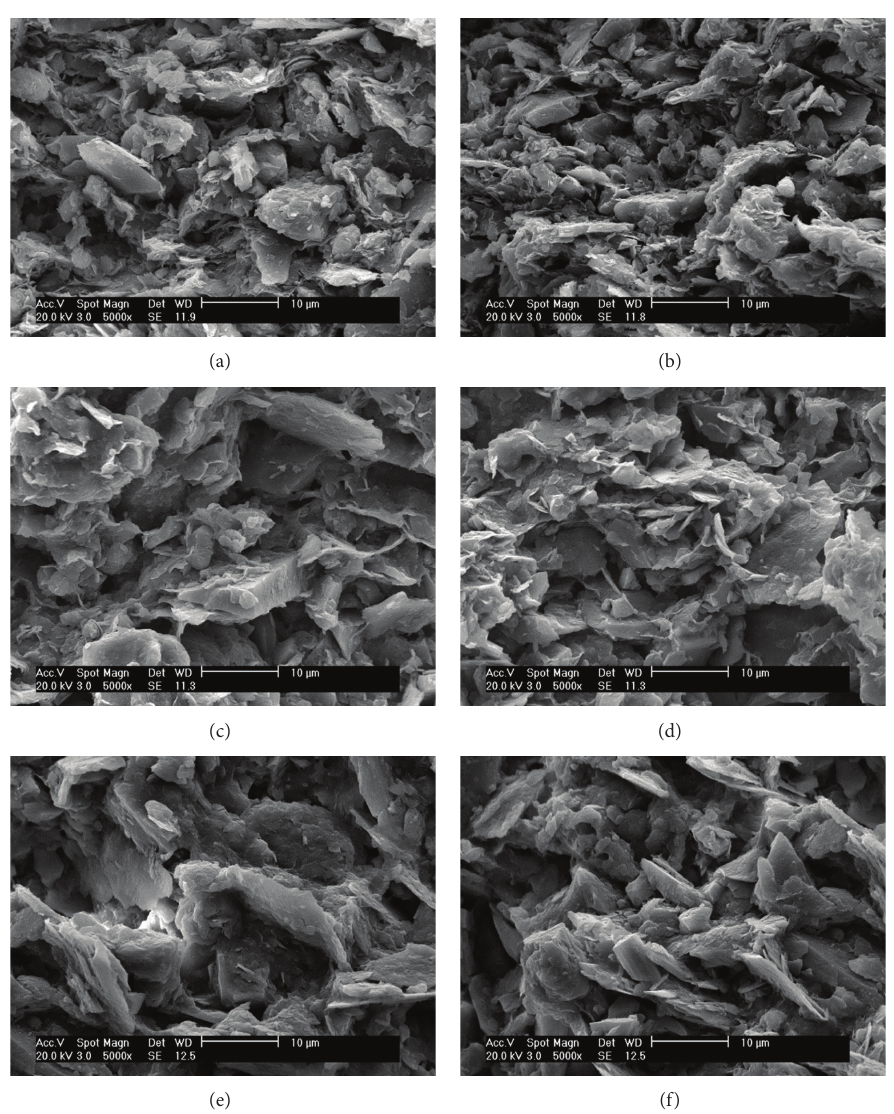
Figure 5: Microstructure of RAC with different replacement and corrosion time. (a) RP = 0% (before test). (b) RP = 0% (8 months corrosion). (c) RP = 30% (before test). (d) RP = 30% (8 months corrosion). (e) RP = 60% (before test). (f) RP = 60% (8 months